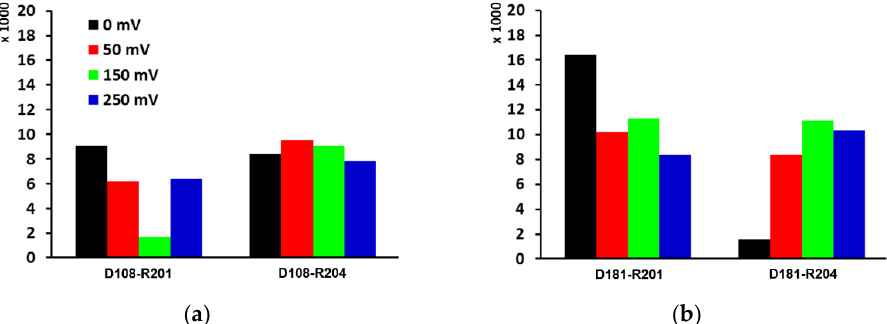
Figure 5. The number of hydrogen bonds of ( a ) Asp108 (on S1 helix) formed with Arg201 (S4) and Arg204 (S4), and of ( b ) Asp181 (S3) formed with Arg201 (S4) and Arg204 (S4) over the simulation times of four simulations. Upon voltage activation, Arg204, the lower residue on the S4 helix, forms a salt ‐ bridge frequently with Asp108 on the S1 helix and Asp181 on the S3 helix. Hydrogen bonds are calculated with a cut ‐ off distance of 3.4 Å and an angle of 30 degrees.